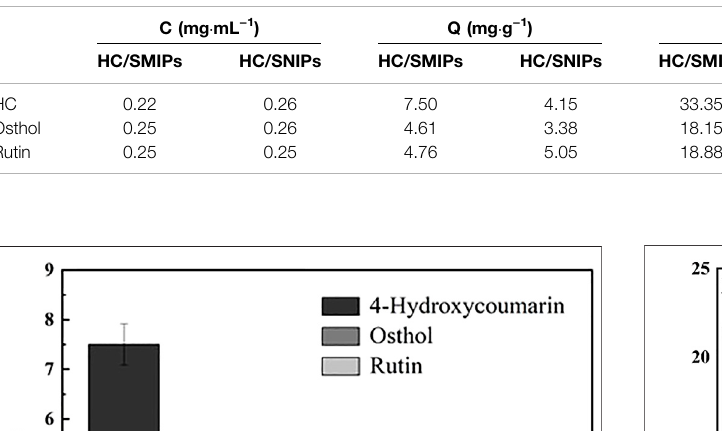
TABLE 2 | The selectivity parameters of HC/SMIPs and HC/SNIPs.